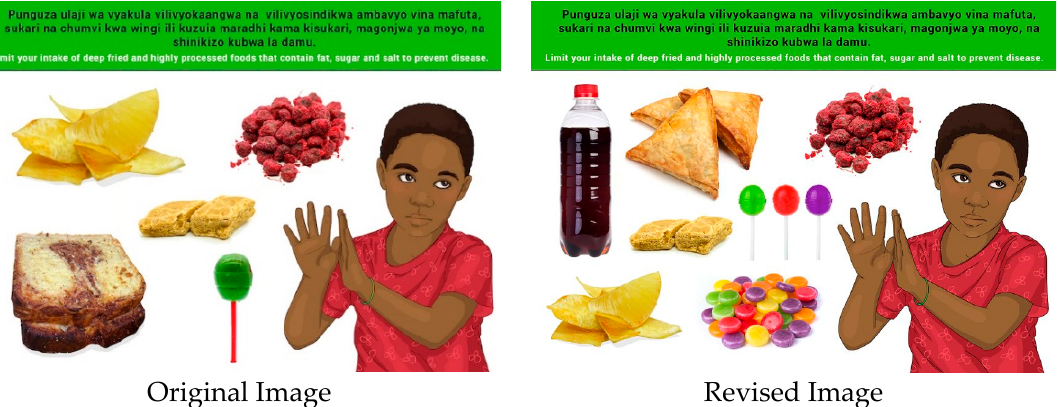
Figure 9. Limit your intake of deep fried and highly processed foods that contain fat, sugar and salt to prevent disease such as high blood pressure, diabetes and heart diseases.